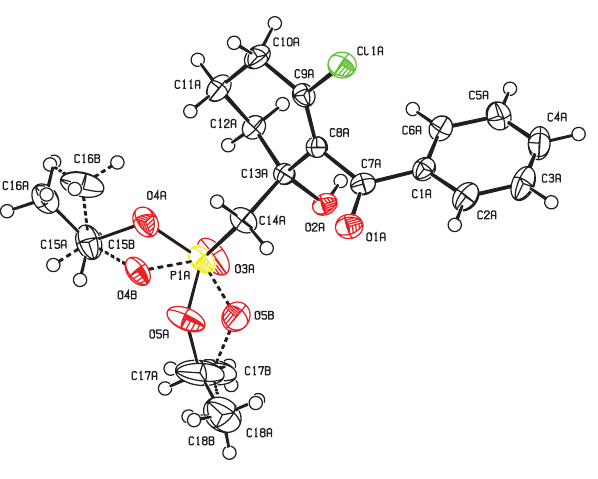
The asymmetric unit of the title crystal structure is shown in the figure. Tables 1 and 2 contain details on crystal structure and measurement conditions and a list of the atoms including atomic coordinates and displacement parameters.